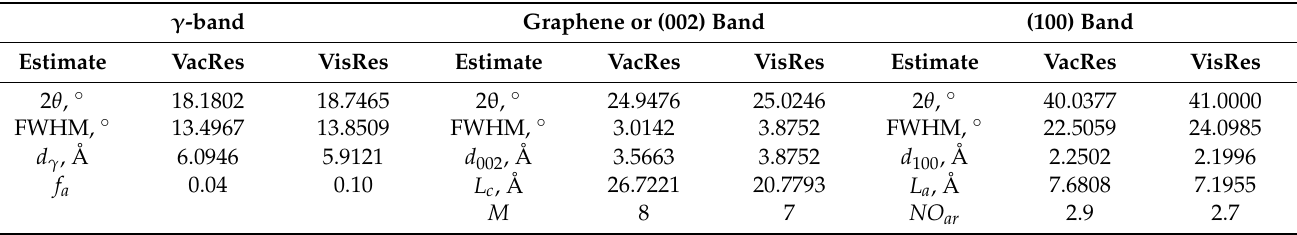
Figure 5. Comparison of diffractograms of asphaltenes from VacRes and VisRes: ( a ) asphaltenes obtained from VacRes and ( b ) asphaltenes obtained from VisRes. Table 3. Crystalline parameters derived from XRD data for petroleum